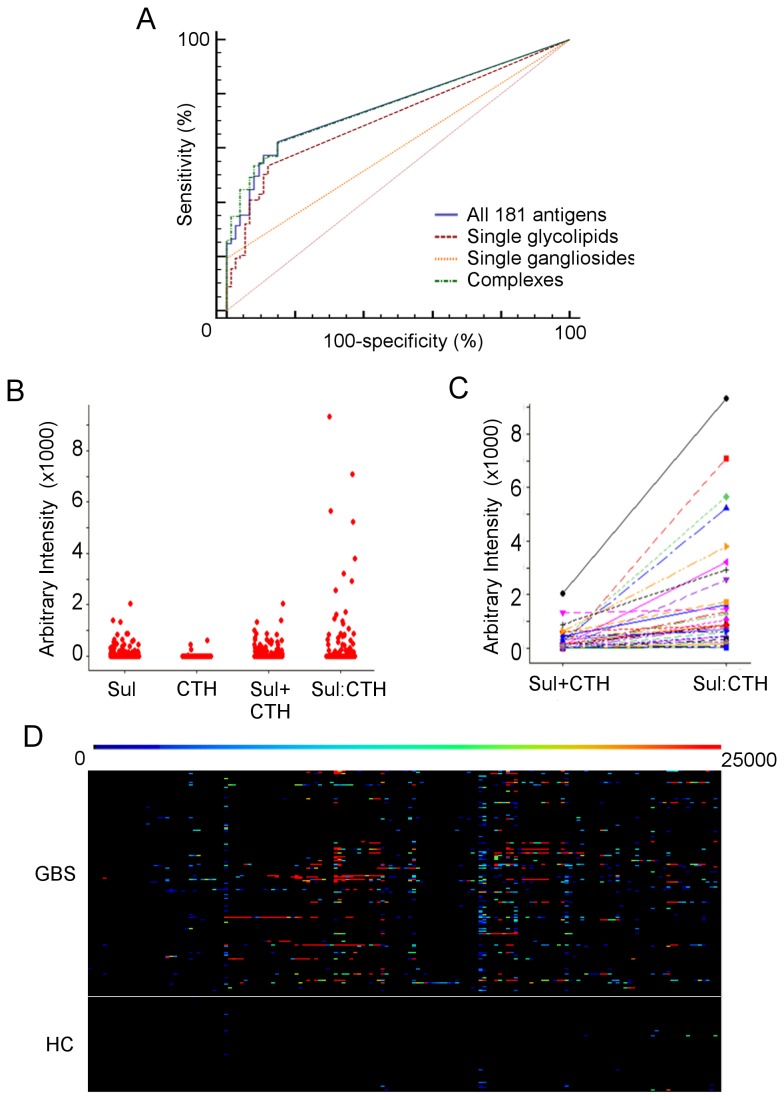
Complex enhanced binding.(A) Receiver operator curves for single ganglioside antigens, single glycolipids, glycolipid complexes, and for all 181 antigens. Complex antigens (dashed green line) afford the best trade-off between sensitivity and specificity.(B) Individual value plots for GBS sera binding intensity to single sulfatide (sul), single CTH, the sum of these single intensities (sulfatide+CTH), and CTH:sulfatide complexes.(C) Comparison between the sum of single sulfatide and CTH binding intensities (sul+CTH) and binding intensity to CTH:sulfatide complexes in individual sera. Each line links the respective values in a single serum. Lines sloping upwards from left to right indicate complex enhanced binding with a single serum.(D) Overview heatmap of corrected complex binding intensities. The intensity value for each complex has been corrected by subtracting the binding intensities of each component glycolipid. Any residual intensity indicates complex enhanced binding. As before, GBS sera lie above and healthy control (HC) sera below the horizontal white line. The same colour scale as Figure 1 has been used. A more detailed, zoomable version of this heatmap, allowing resolution of results for each complex antigen and each serum, is available online (Figure S3).